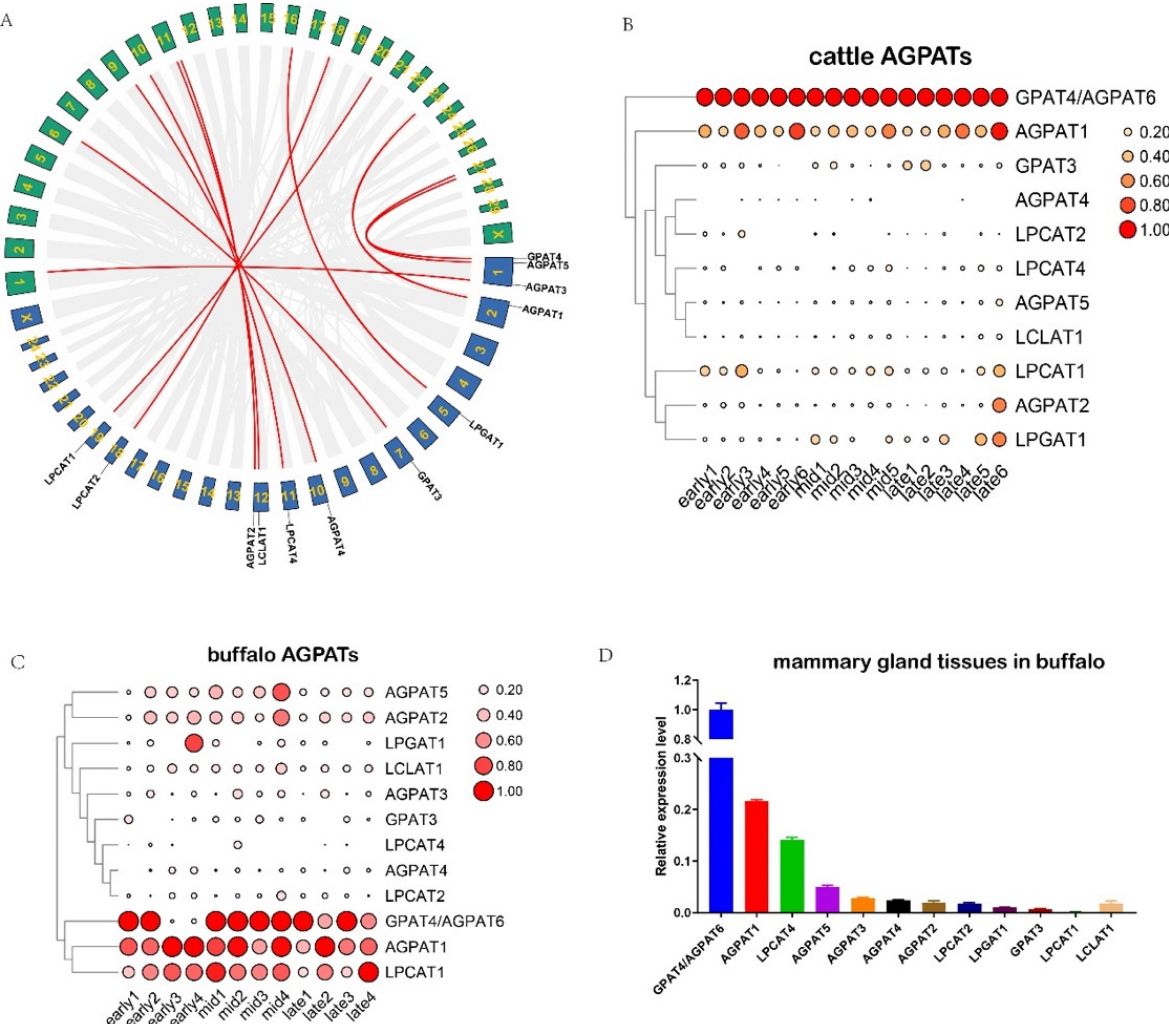
Figure 2. Collinearity and expression analysis of AGPAT family between buffalo and cattle. ( A ) Collinearity analysis of AGPAT family between buffalo and cattle. The green frame indicates cattle chromosomes, the blue frame indicates buffalo chromosomes, and the red line represents collinearity gene pairs. ( B ) Transcriptome analysis of cattle AGPAT family. The area indicates the scale size. ( C ) Transcriptome analysis of buffalo AGPAT family. The area indicates the scale size. ( D ) Expression analysis of buffalo AGPAT genes in mammary gland